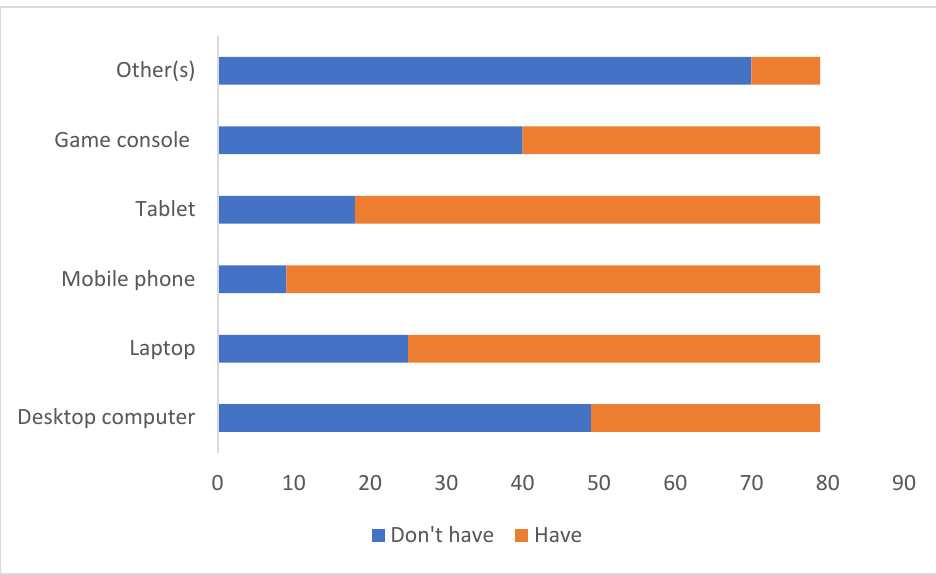
Figure 2. 5th grade s tudent’s ownership of digital devices .